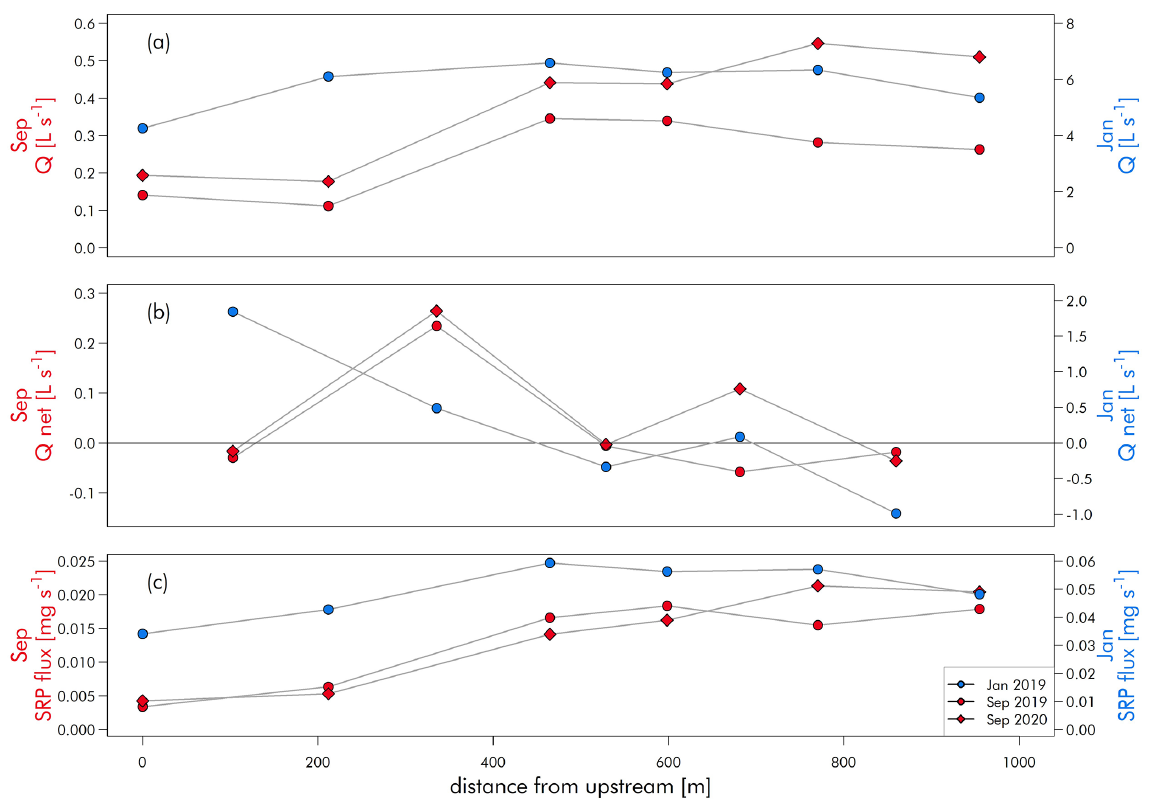
Figure 4. Discharge, net discharge gains and losses, and SRP flux along the stream during the three sampling campaigns.